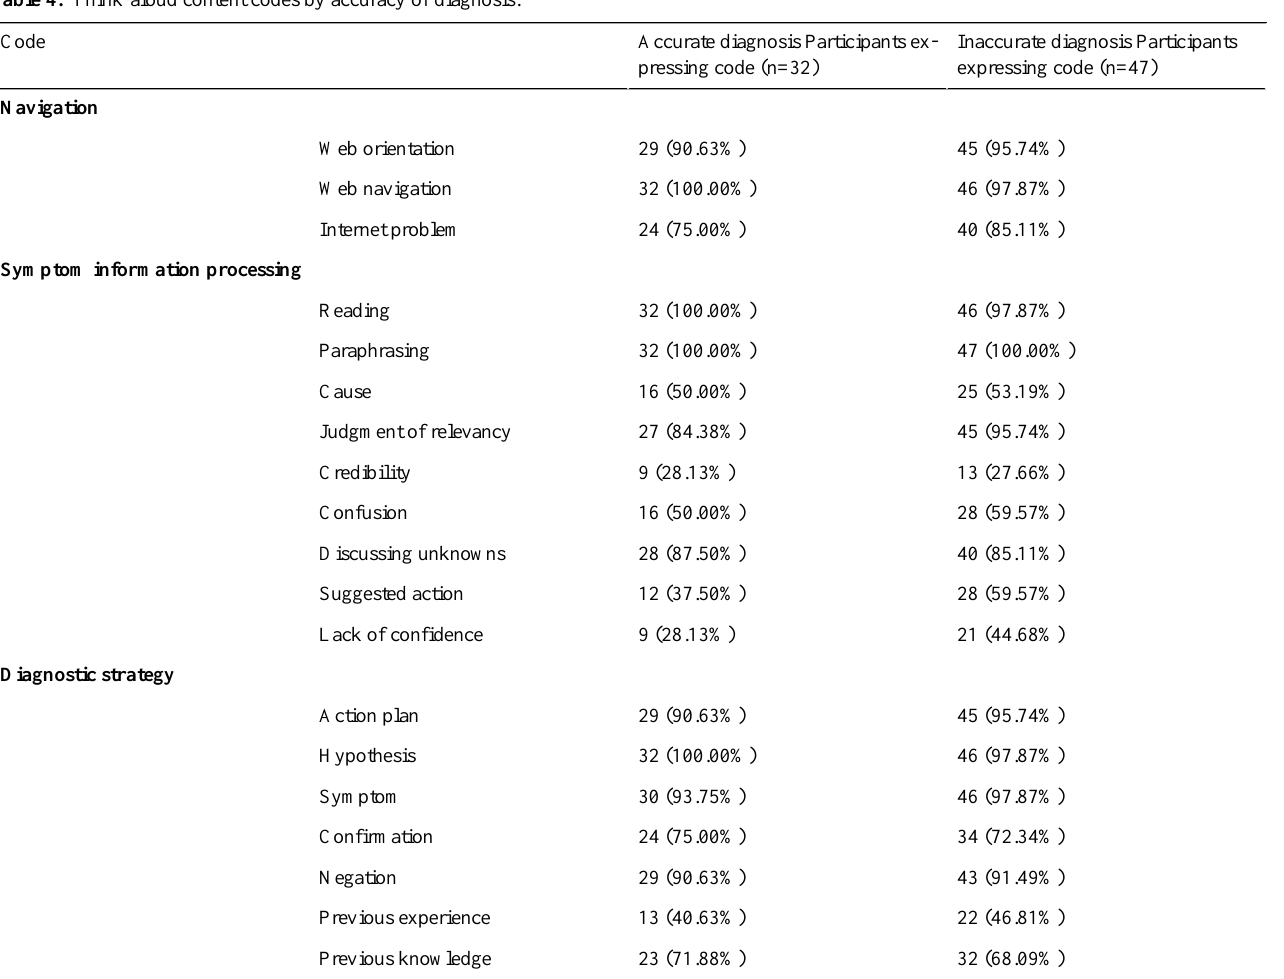
Table 4. Think-aloud content codes by accuracy of diagnosis.